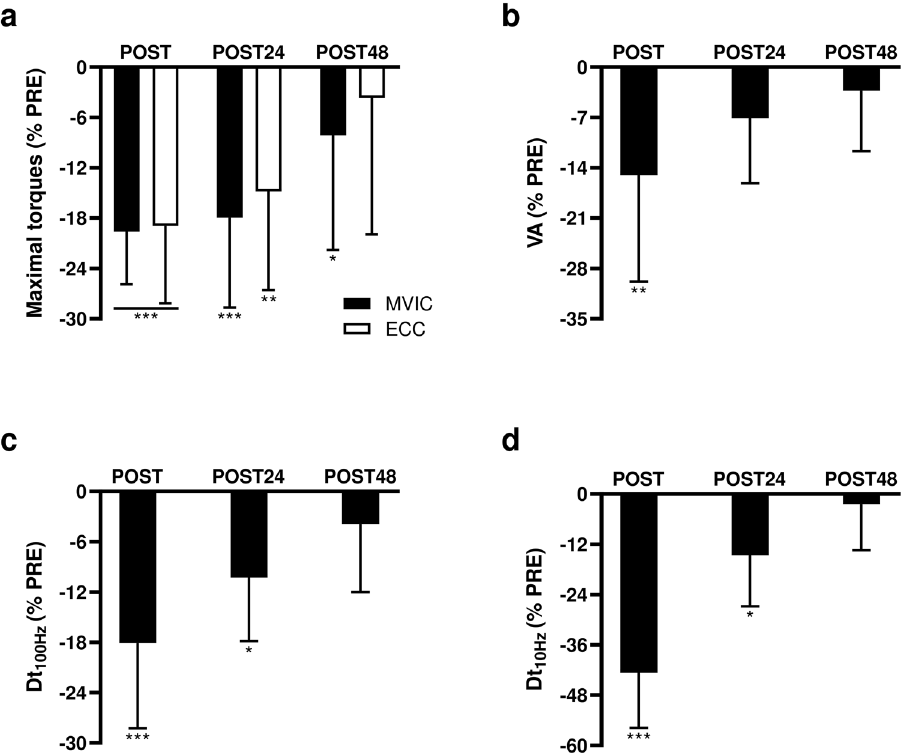
Figure 2. Effects of the submaximal eccentric exercise on knee extensor’s neuromuscular function. Percent changes from pre-exercise values in ( a ) maximal voluntary torque production (MVIC in black bars and ECC in white bars), ( b ) VA , ( c ) Dt 100 Hz and ( d ) Dt 10 Hz . *, ** and ***Significantly different from PRE values at p < 0.05, p < 0.01 and p < 0.001, respectively . MVIC Maximal Voluntary Isometric Contraction, ECC Maximal voluntary eccentric contraction, VA Voluntary Activation level, Dt 100 Hz potentiated doublet amplitude at 100 Hz, Dt 10 Hz potentiated doublet amplitude at 10 Hz. The statistical analyses of this figure were performed using